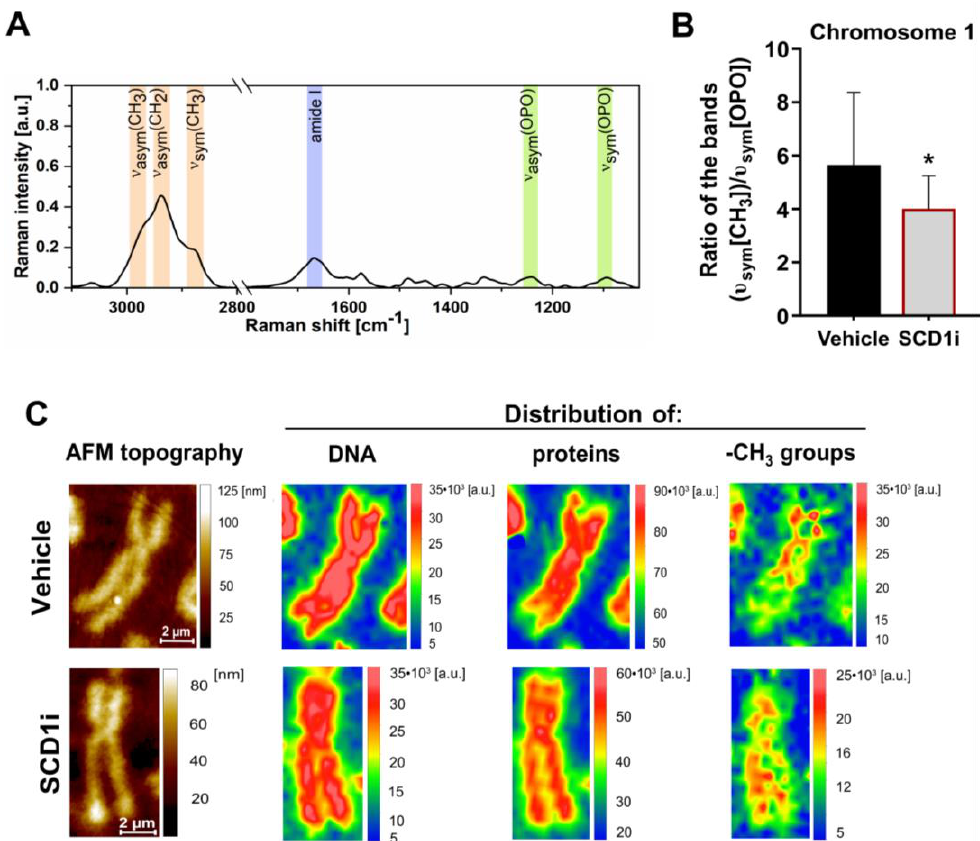
Figure 2. Raman spectroscopic analysis of the effect of SCD1 inhibition on the spatial distribution of -CH 3 groups within single chromosome 1 in INS-1E cells. ( A ) Average Raman spectrum of chromosomes 1 ( n = 15, spectra obtained using empty modeling analysis) that were isolated from INS-1E cells (smoothed, Savitzky – Golay filter, second order, 11 pt). ( B ) Estimation of global methylation levels in single chromosome 1 from control INS-1E cells and cells that were treated with the SCD1 inhibitor, presented as an average integration value ( n = 6) of the band in the spectral range of 2900 – 2850 cm − 1 ( υ sym (CH 3 )), corresponding to the distribution of -CH 3 groups and normalized to the band in the spectral range of 1110 – 1070 cm − 1 ( υ sym (OPO)), corresponding to the distribution of DNA. ( C ) Atomic force microscopy (AFM) and Raman spectroscopic maps of chromosome 1 — isolated from INS-1E cells, showing the topography of single chromosome 1 and the spatial distribution of integrated bands, corresponding to the distribution of DNA, proteins (mainly histones), and methyl groups. The data are expressed as mean ± SD. * p < 0.01, vs. vehicle.